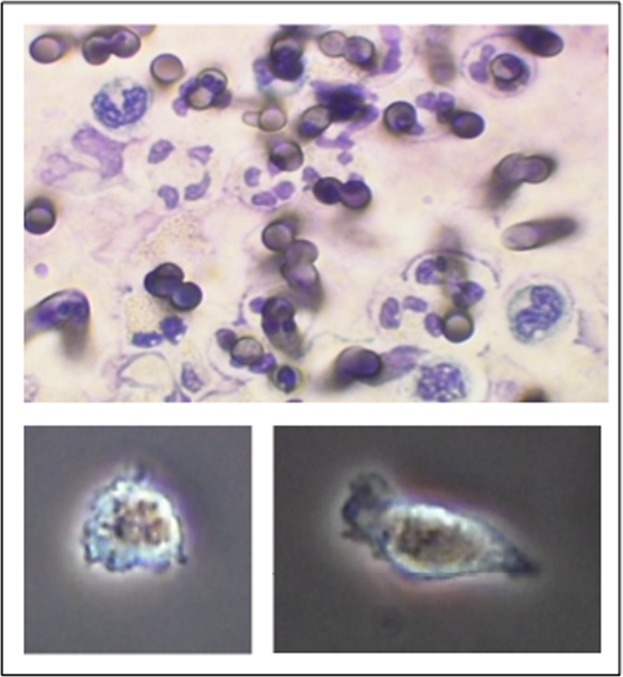
Shape change of PMN during migration through the membrane pores in a fluorescence microscopy analyse Diameter of the pores: 3 μm, see the bevelled, diagonal diameter.